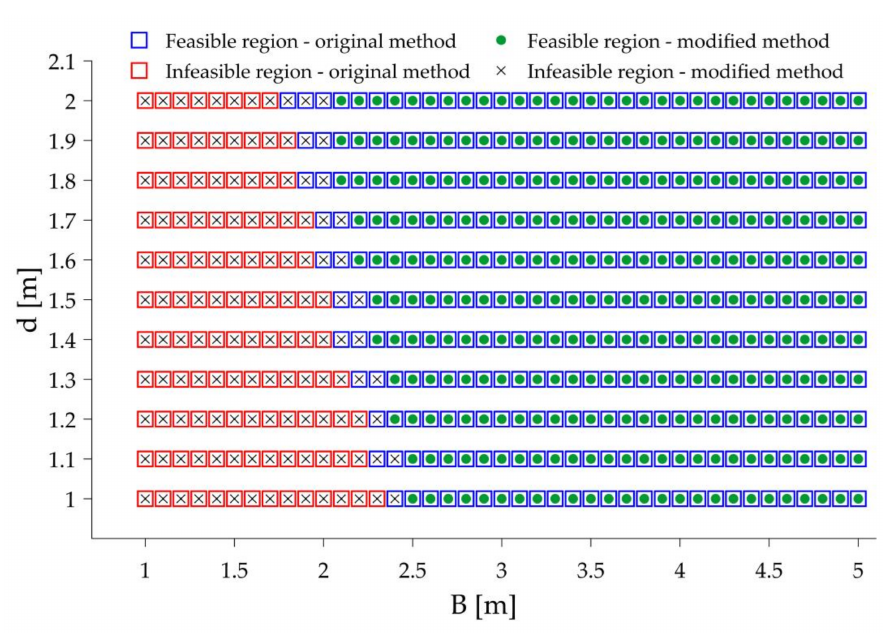
Figure 13. The result comparison of the original and modified RGD procedure for the decision